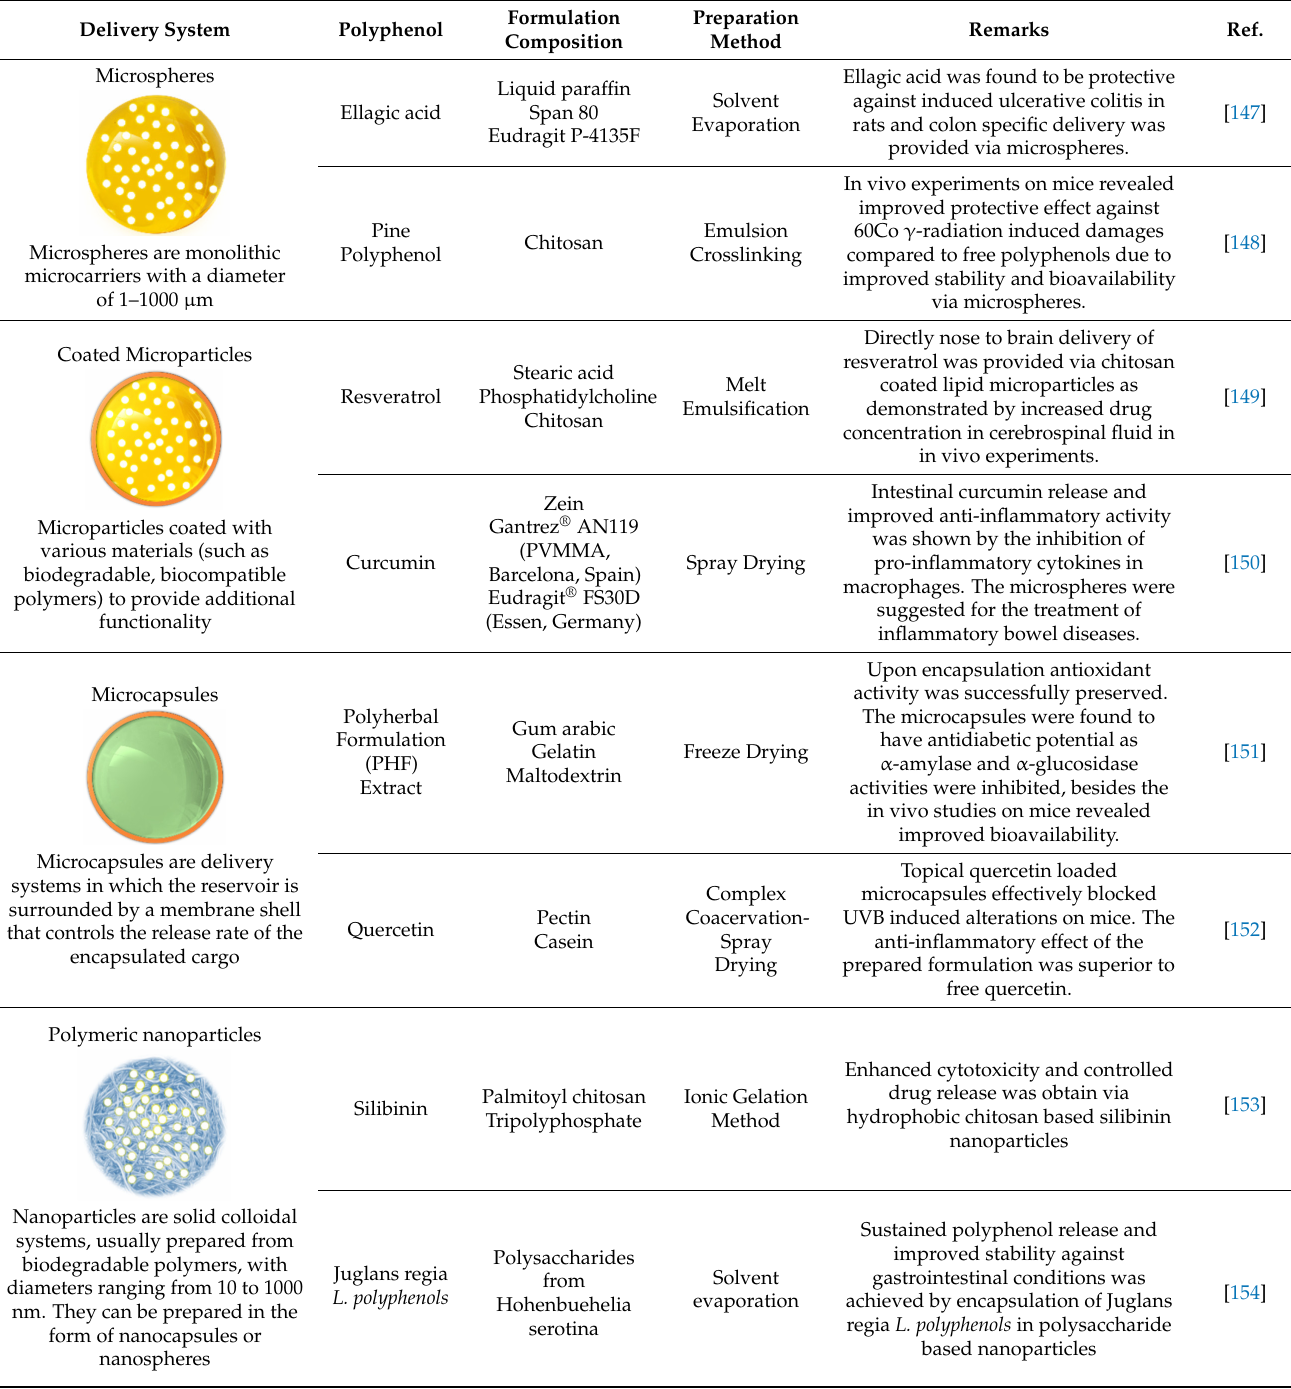
Table 5. Examples of Micro-/Nano-Particulate Delivery System Containing